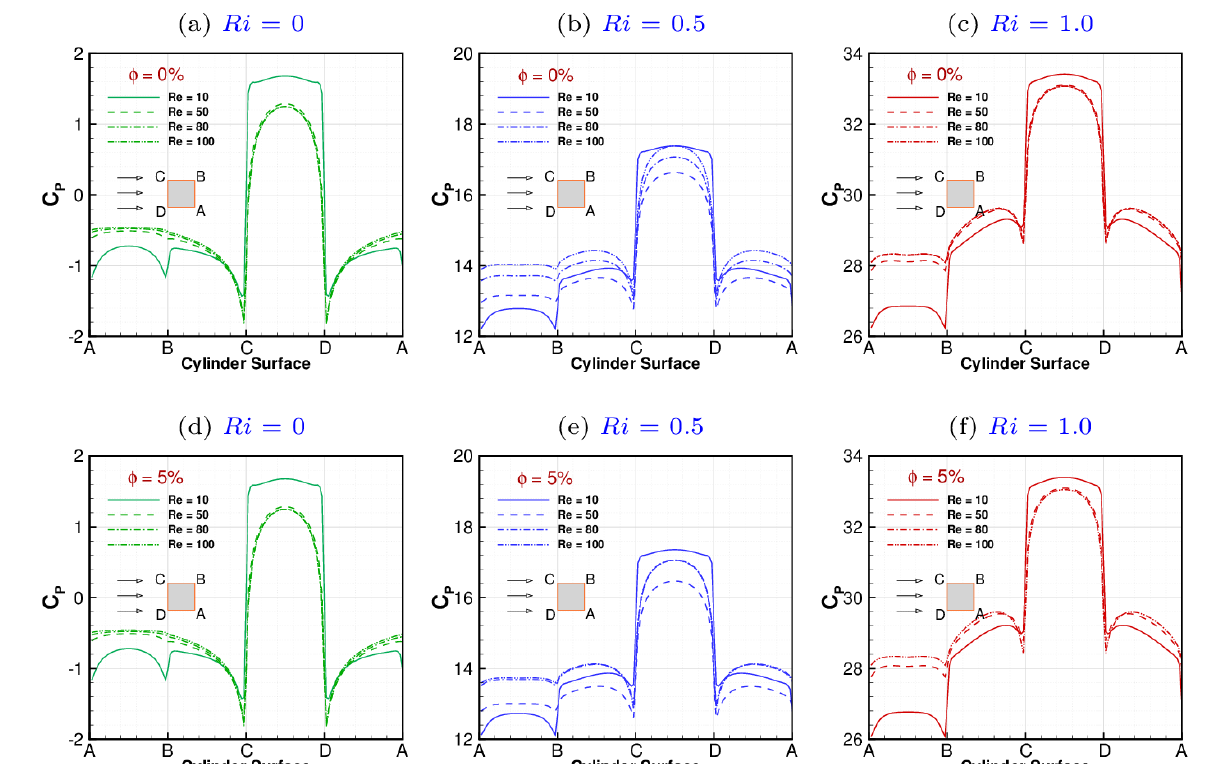
Figure 8. Distribution of pressure coefficient ( C P ) on the surface of the heated cylinder for different values of Re, Ri, and φ .